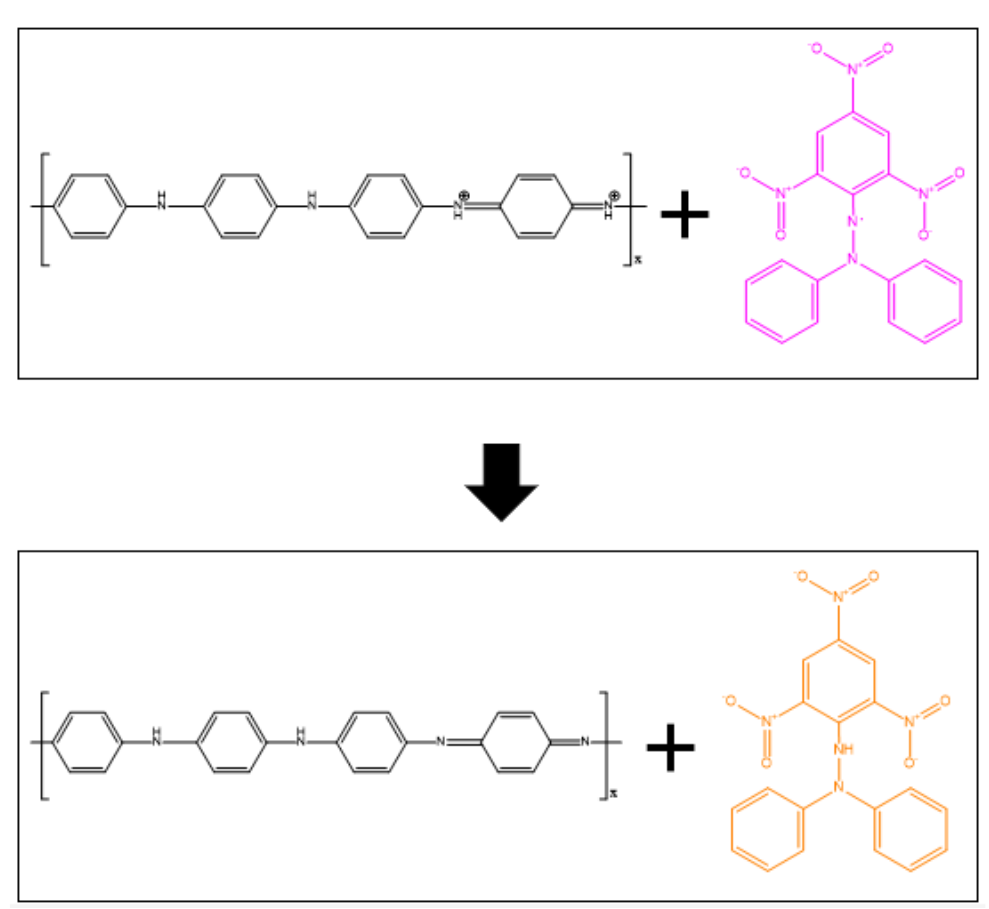
Figure 7. Proposed mechanism of the interaction between PANI and DPPH [50].